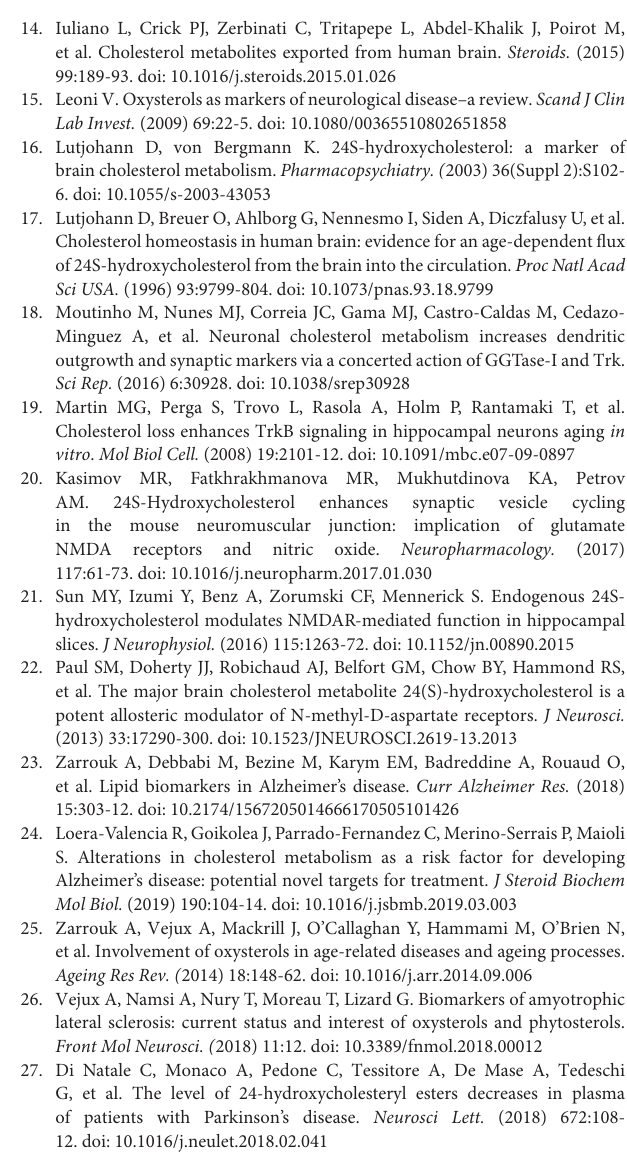
Supplementary Figure 1 | Differences in plasma oxysterol levels between antipsychotic-naive and antipsychotic-treated patients with schizophrenia. The plasma 24OHC levels and 27OHC levels in antipsychotic-naive or antipsychotic-treated patients with schizophrenia are shown in (A,B) , respectively. No significant difference was found between these two groups in